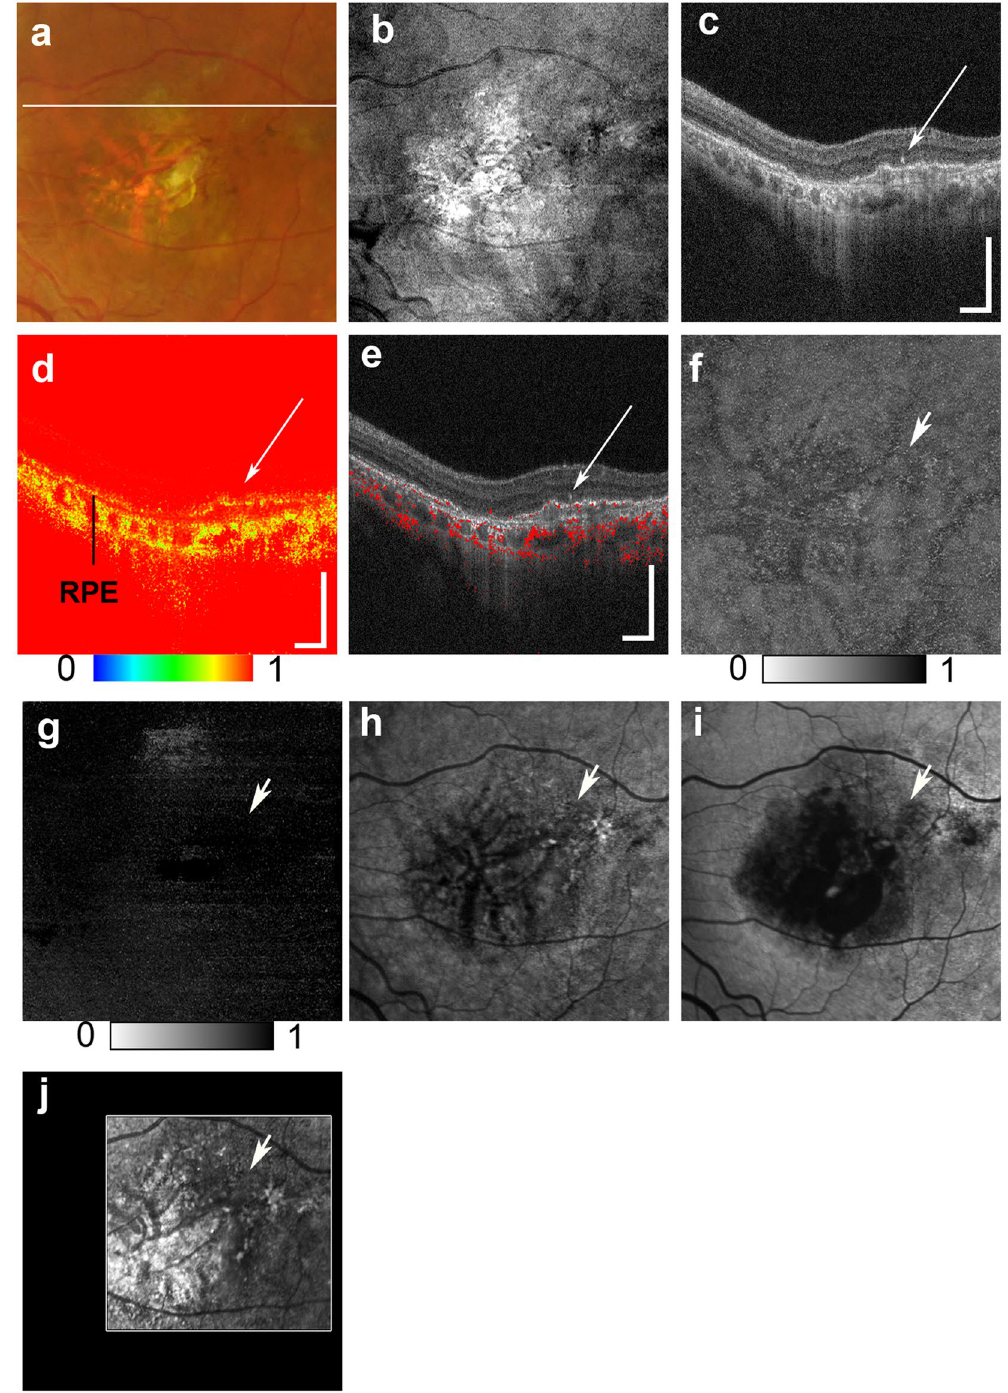
Figure 4. Multimodal imaging of end-stage AMD with subretinal fibrosis from the left eye of a 61-year-old male. The color fundus photography image ( a ) shows subretinal fibrosis on the macula, and the white line indicates the scan line of the PS-OCT B-scan images ( c,d,e ). The en face projection of a standard OCT image ( b ). The standard OCT B-scan image ( c ) shows HRF (white arrow). The DOPU B-scan image ( d ). Composite DOPU B-scan OCT images (e) . The scale bars represent 500 μ m × 500 μ m. An en face projection image of the minimum DOPU along the whole depth ( f ) and an en face projection of the minimum DOPU anterior to the RPE ( g ). The PS-OCT shows the absence of depolarization at HRF (d,e,f,g ; white arrows). The absence of hyper-AF in NIR-AF ( h ), SW-AF ( i ) or depolarization in PS-SLO ( j ) at corresponding locations of HRF (white arrows) is consistent with the absence of RPE migration at HRF. All abbreviations used are as defined in the figure legends for Figs